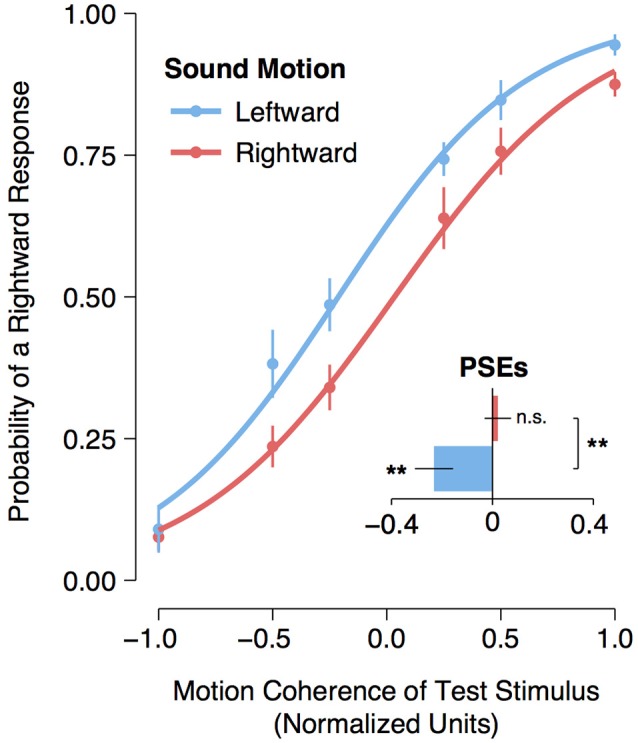
Visual motion aftereffect following leftward and rightward auditory motion. Curves represent logistic regression functions fitted to group data. The data points represent the mean frequency of a “rightward” response. Normalized coherence values are represented on the x-axis, with negative values arbitrarily assigned to leftward moving motion displays and positive values assigned to rightward moving displays. The bar plot represents the participants' mean point of subjective equality (PSE) for the leftward and rightward auditory motion adaptation conditions. Asterisks next to bars indicate a significant (p < 0.01) shift in the participants' PSE compared to a normalized coherence test value of zero, and “n.s.” indicates that there was no significant shift (p > 0.05) from zero. Asterisks between bars indicate a significant (p < 0.01) difference between the participants' PSEs for the rightward and leftward auditory motion adaptation conditions. Error bars represent ± SEMs.